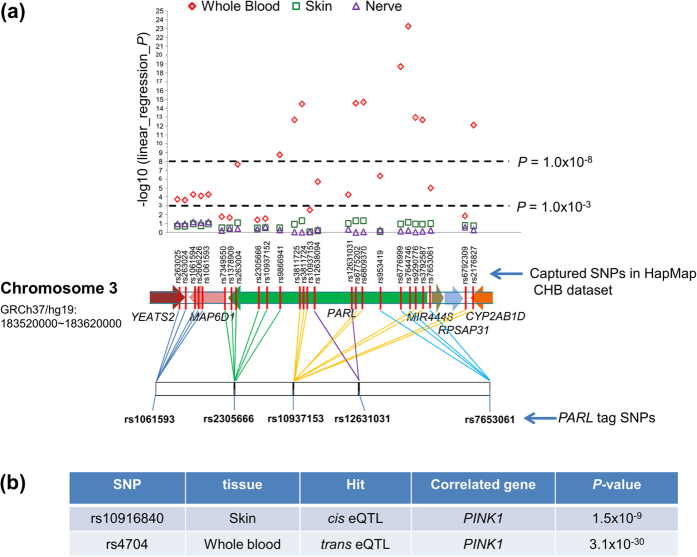
eQTL analysis of the PARL and PINK1 genes.cis and trans eQTL of the PARL and PINK1 tag SNPs in human blood, skin and nerve tissues were identified by using the GTEx (http://www.gtexportal.org/home)38 and HaploReg dataset (http://www.broadinstitute.org/mammals/haploreg/haploreg.php)54.